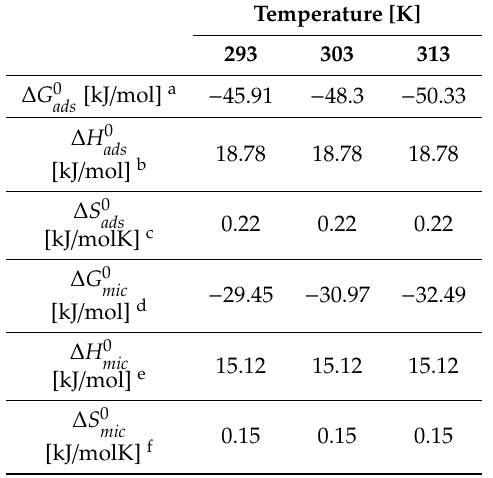
Table 2. The values of standard Gibbs free energy ( ∆ G 0 entropy ( ∆ S 0 ) of TS-OE12 adsorption as well as standard Gibbs free energy ( ∆ G 0 ads